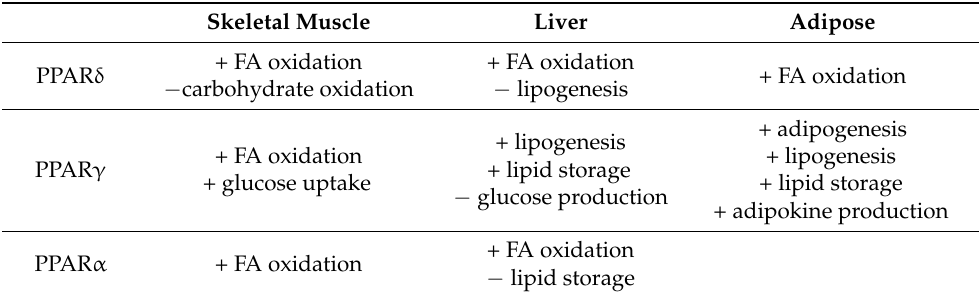
Table 1. Regulation of lipid and carbohydrate metabolism by PPARs in skeletal muscle, adipose tissue and